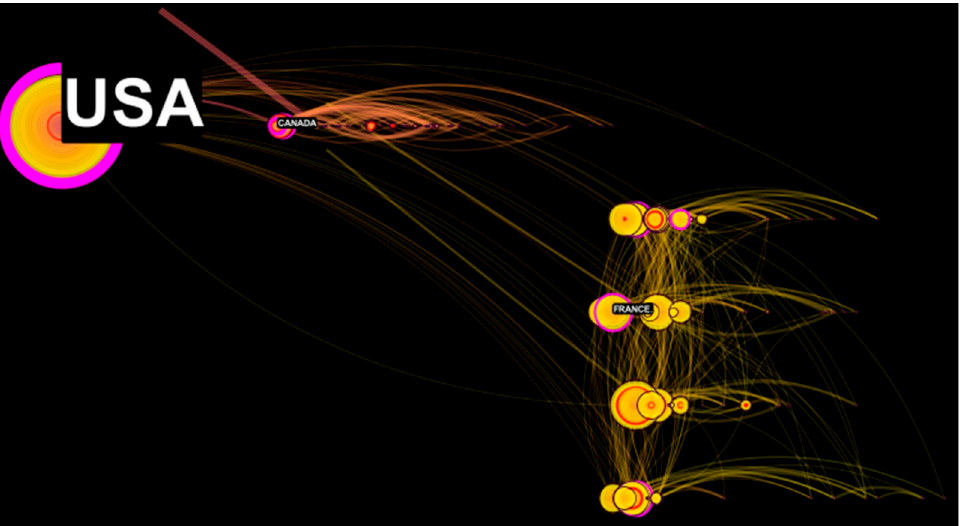
Figure 6. The most cited countries in studies related to the impacts of climate change on heavy metal contamination in coastal areas, based on the Web of Science Core Collection database